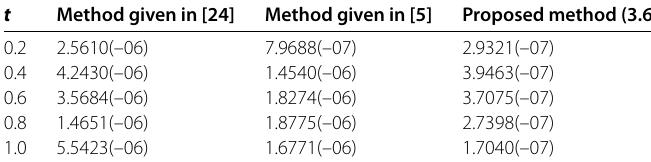
Table 5 Example 1: Case 1.2(b): Maximum absolute errors at δ = 2